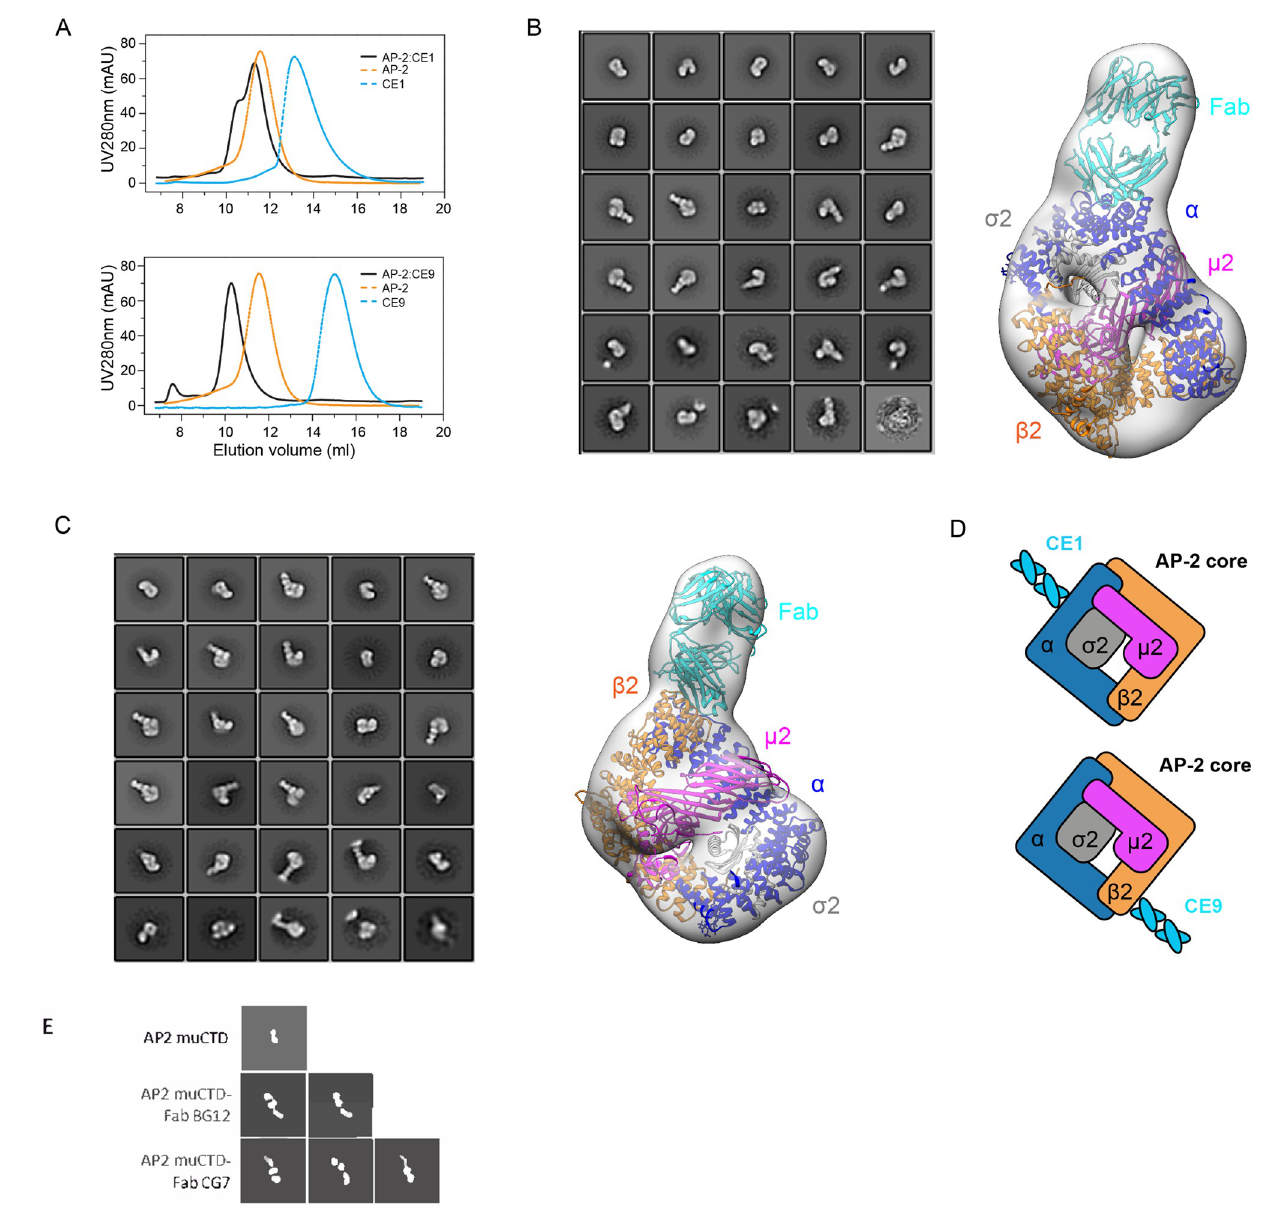
Fig 8. Characterization of Fabs that bind the AP2 complex. A . SEC profiles of AP2 core:CE1 Fab (black in upper panel), AP2 core:CE9 Fab (black in lower panel), AP-2 core alone (dashed orange) and Fab alone (dashed cyan) on a Superdex 200 10/300GL column. Single particle negative stain EM study of AP-2 core: CE1 Fab. B . or AP-2 core:CE9 Fab C . The left panel is 2D class averages for AP-2:Fab complex. The right panel showed that the atomic structures of a Fab (PDB: 3SQO and chain H,L in cyan) and an AP-2 core (PDB: 2VGL) were docked in the density map as rigid bodies (AP2 α in blue, β 2 in orange, μ 2 in magenta and σ 2 in gray). D . Cartoon representation of Fabs (CE1 in upper panel, CE2 in lower panel) binding to AP-2 core. E . Representative negative stain 2D class averages of AP2 muCTD with BG12, CG7 or